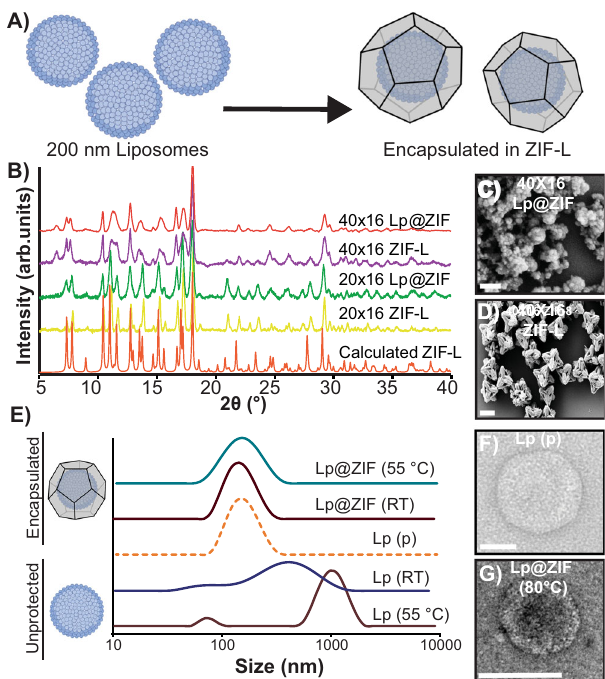
Fig. 2 Characterization of arti fi cial lipid bilayers embedded in ZIF. A Biomolecular nucleation of liposomes in ZIF. B PXRD spectra of ZIF liposome complexes (Lp@ZIF) and ZIF controls. 40 × 16 Lp@ZIF (red), 40 × 16 ZIF-L (purple), 20 × 16 Lp@ZIF (green), 20 × 16 ZIF-L (yellow), and calculated ZIF-L (orange). SEM micrograph of ( C ) 40 × 16 Lp@ZIF (Scale bar = 200 nm) and ( D ) 40 × 16 pristine ZIF (Scale bar = 2 μ m). E DLS pro fi les obtained for immobilized liposomes exposed at high temperatures (after exfoliation) compared to native and nonencapsulated liposomes. Lp@ZIF 55 °C (green), Lp@ZIF RT (brown), Lp pristine (orange-dashed line), Lp RT (blue), and Lp 55 °C (dark-pink). F TEM micrograph of pristine liposome (Scale bar = 50 nm) and ( G ) 40 × 16 Lp@ZIF following exfoliation after exposure to 80 °C for 5 min (Scale bar = 100